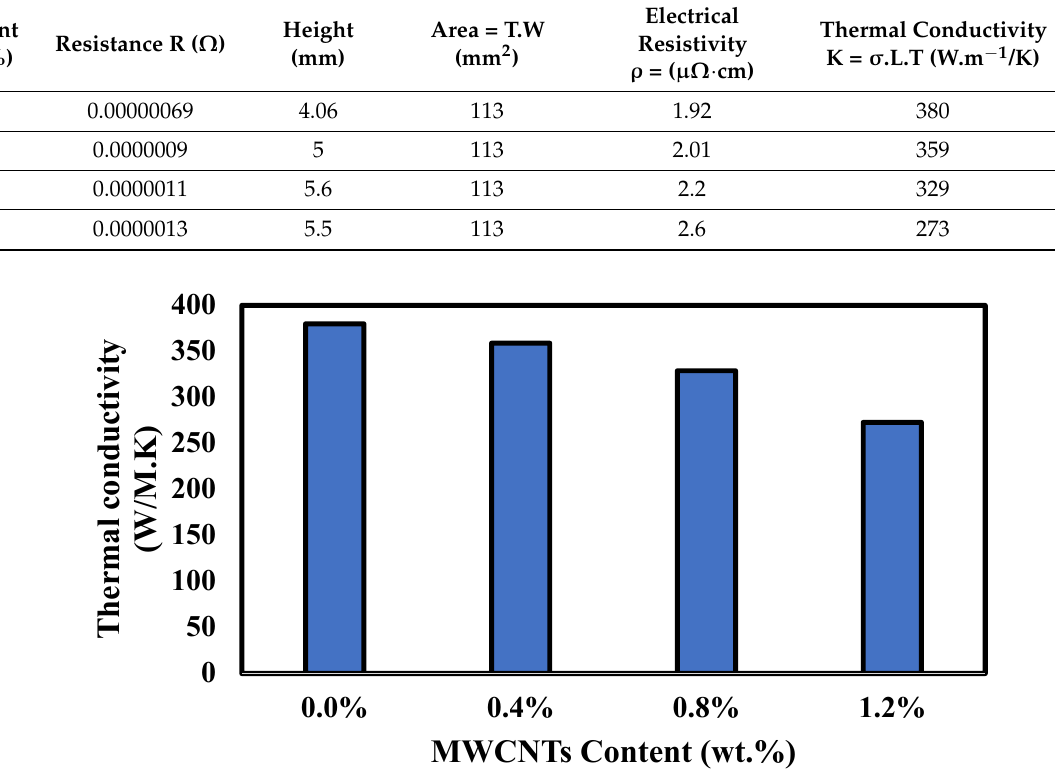
Figure 7. Thermal conductivity of MWCNT content on Cu nanocomposites.